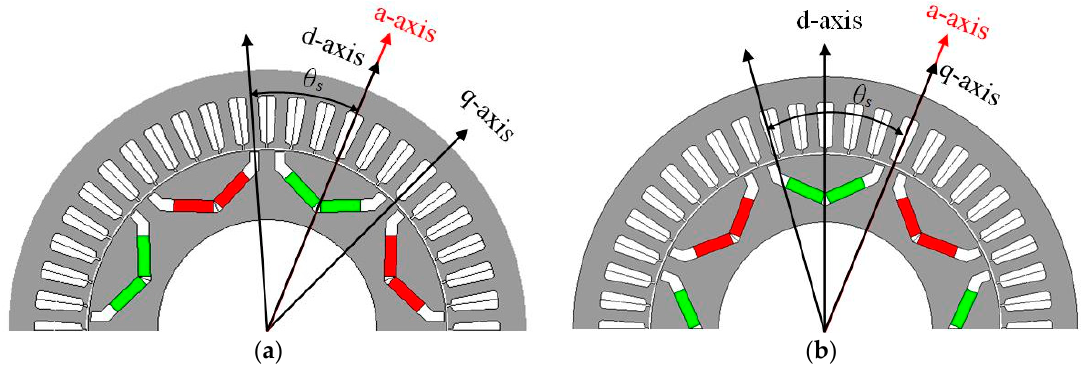
Figure 6. Model with different rotor position: ( a ) d ‐ axis overlaps with a ‐ axis; ( b ) q ‐ axis overlaps with a ‐ axis.